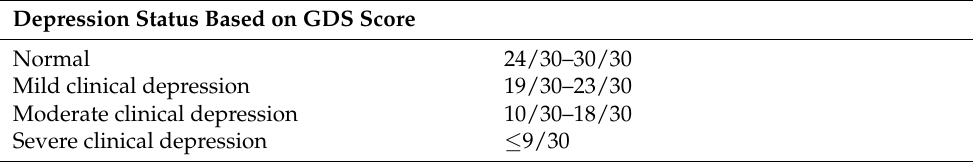
Table 3. Assessment criteria of cognitive status based on GDS score (range 0–30).